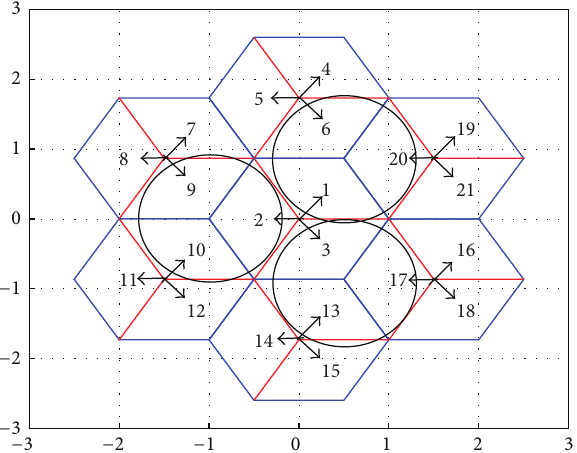
Figure 3: Cellular configuration and sets of adjacent